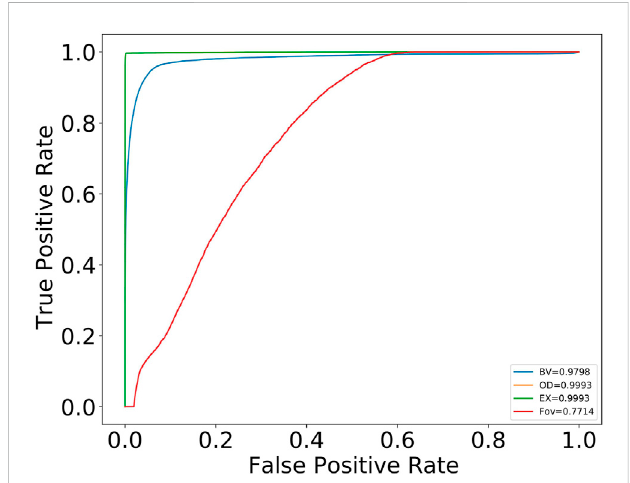
FIGURE 12 ROCcurveforBVs,OD,andmaculastructuresandthepathological indicator, exudates. BVresultsareontheDRIVEtestdataset.OD, macula (FOV), and exudates (EX) are on the IDRiD dataset.